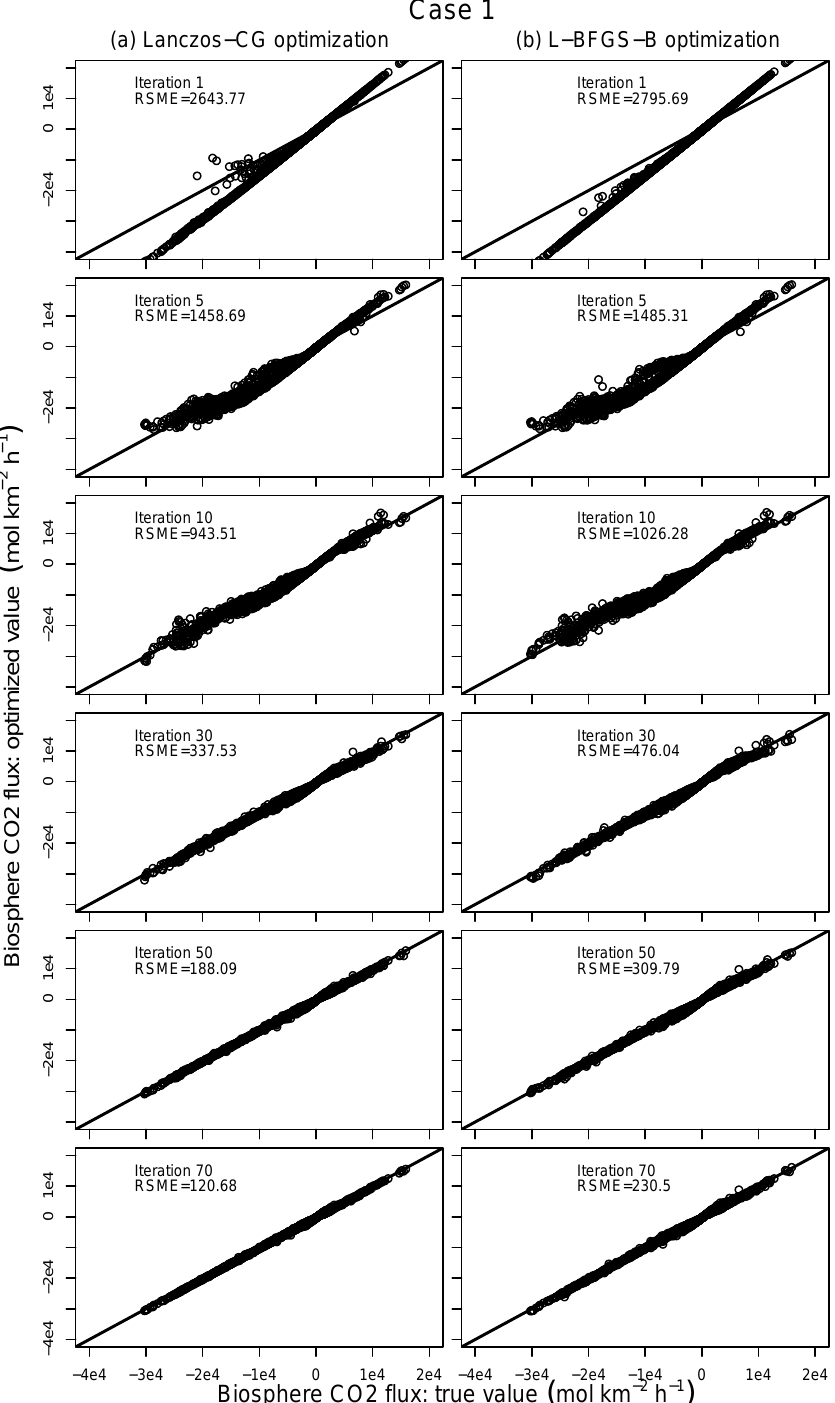
Figure 14. Comparison between the true and optimized CO 2 fluxes by Lanczos-CG (left column) and L-BFGS-B (right column) in the inverse modeling experiment (Case 1). The comparison and RMSE after the 1st, 5th, 10th, 30th, 50th, and 70th iterations are shown in the figure. All iterations of Lanczos-CG are from one outer